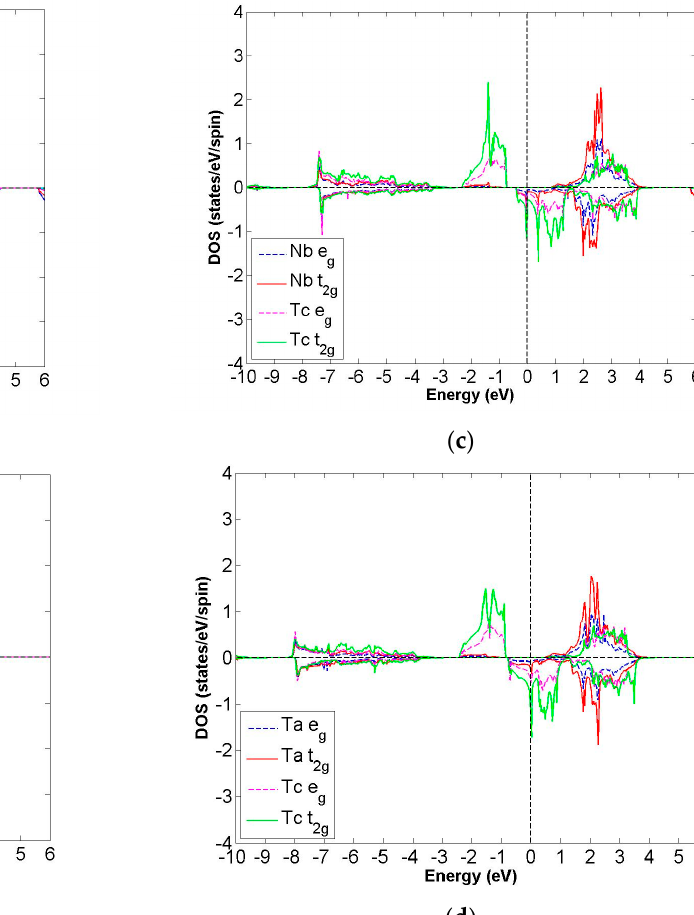
Figure 4. Under GGA + U (U of Nb, Ta and Tc set up as 2) schemes, the calculated total and partial DOS values of ( a ) Pb 2 NbTcO 6 , ( b ) Pb 2 TaTcO 6 and the partial DOS of e g and t 2g spin orbitals for ( c ) Nb and Tc and ( d ) Ta and Tc.